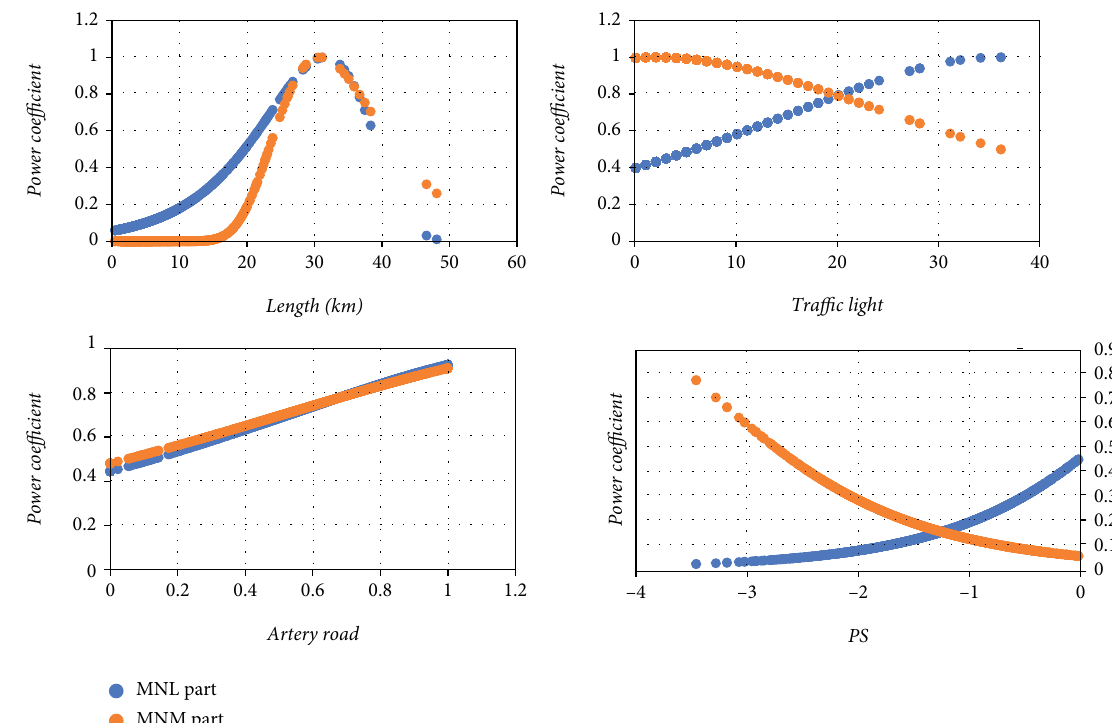
Figure 8: Scatter plots of individual power coe ffi cients of di ff erent